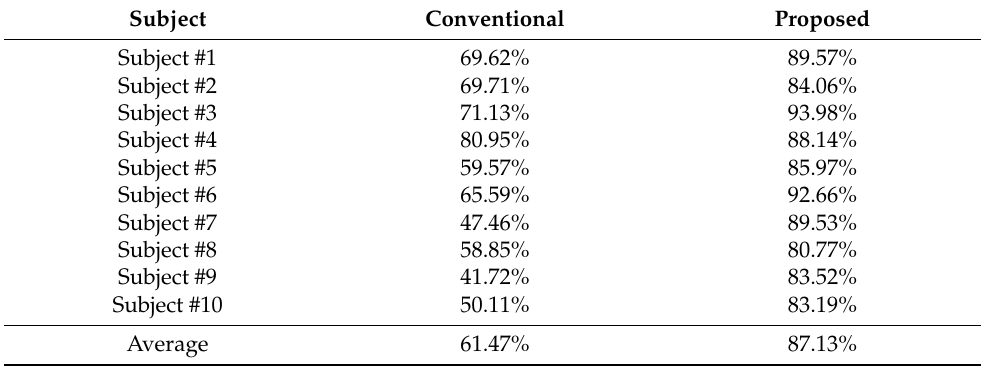
Table 4. Comparison of respiratory rate accuracy for the case shown in Figure 5c.